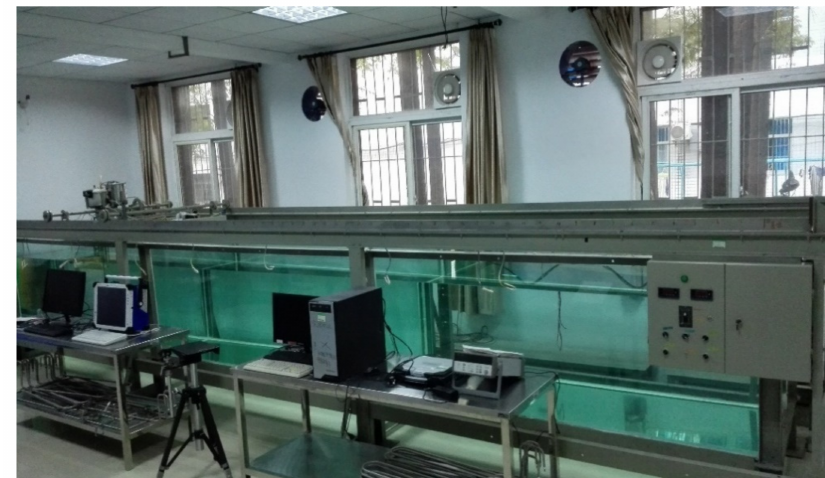
Figure 12. Experimental pool.